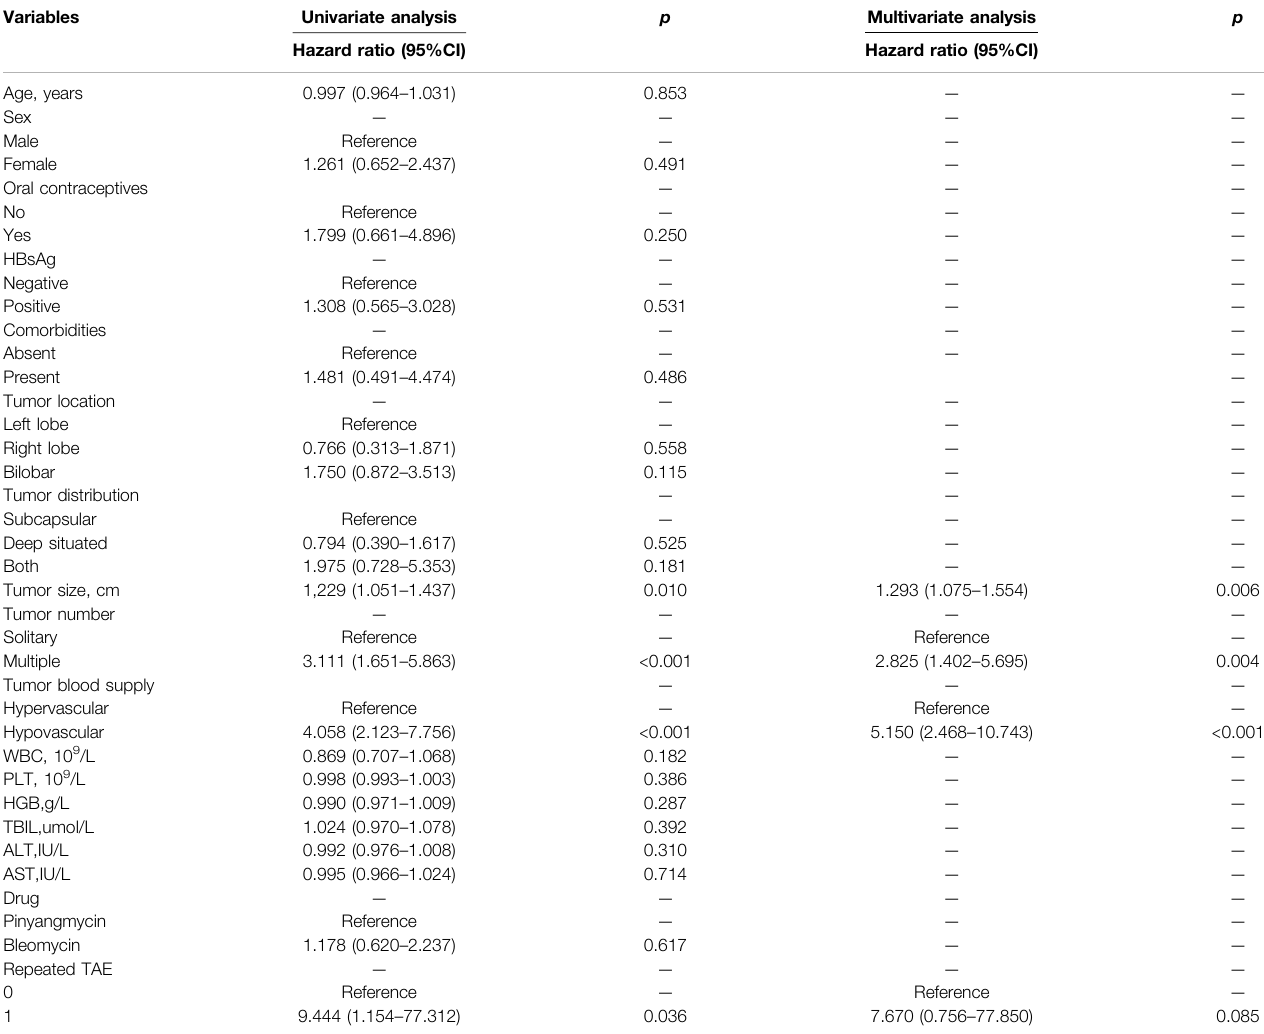
TABLE 2 | Univariate and multivariate analyses of predictive factors associated with tumor response to TAE in the training cohort. Variables